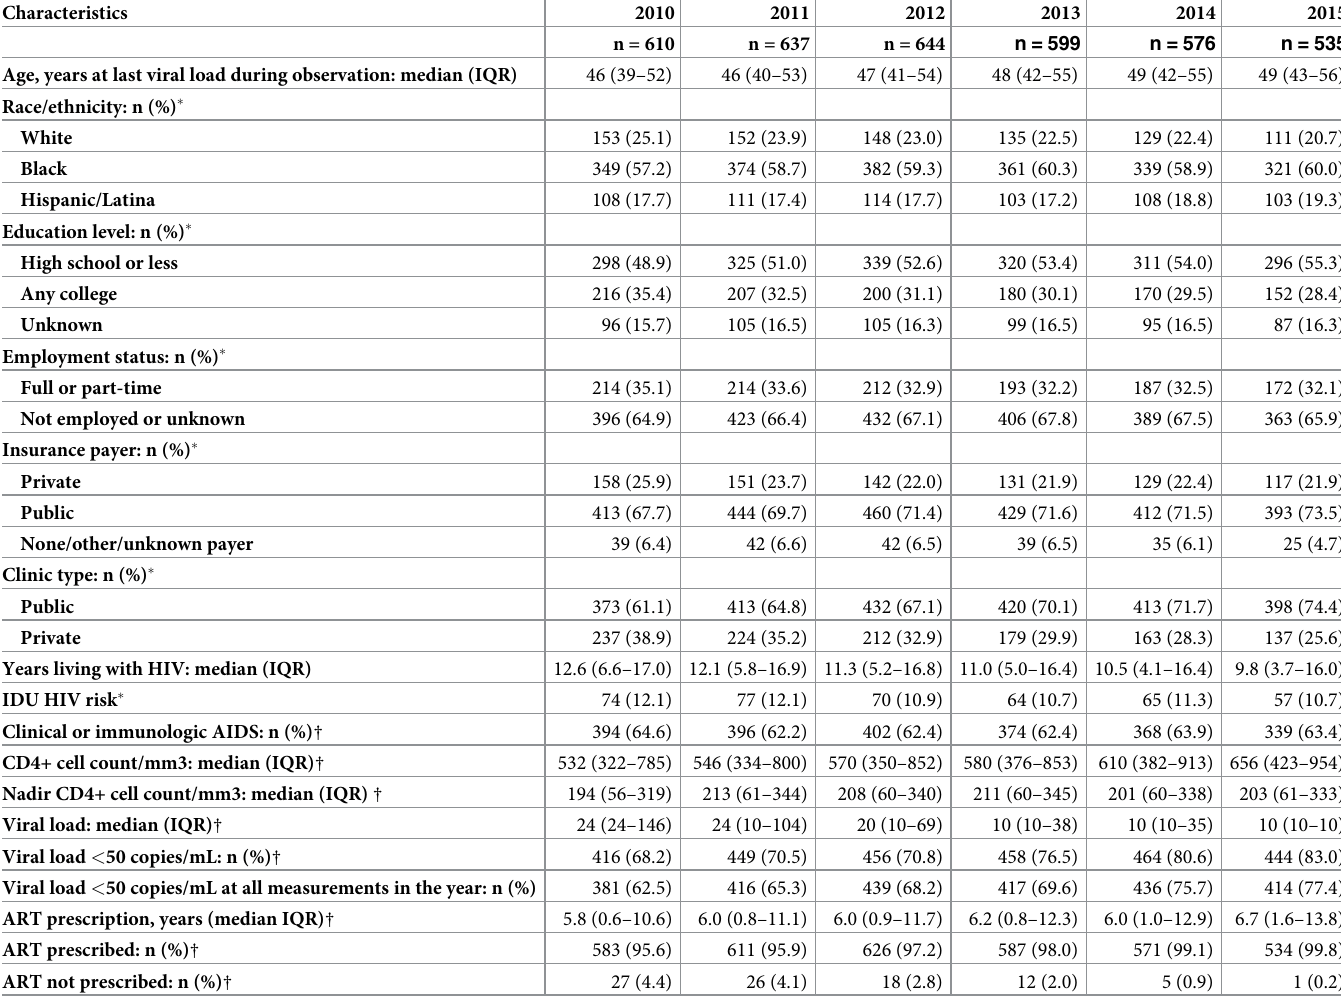
Table 2. Characteristics of women receiving HIV Care, by year, the HIV Outpatient Study, 2010–2015 (N = 809).